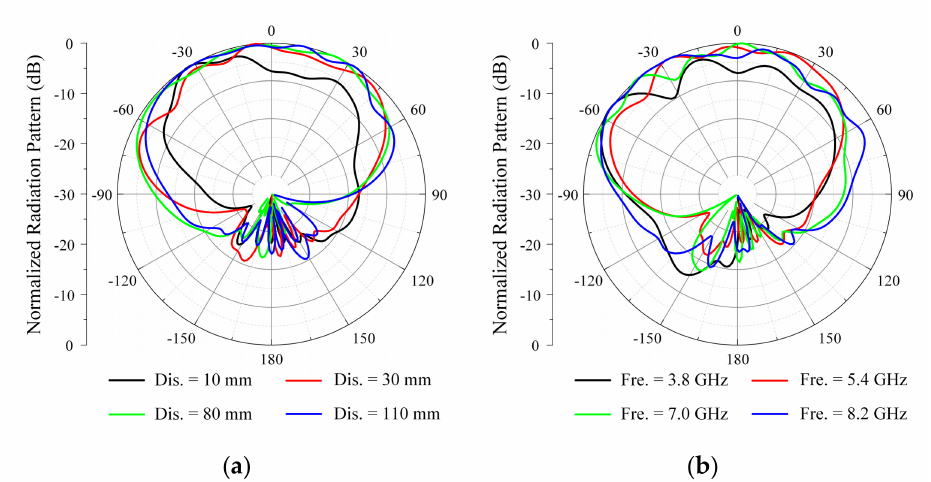
Figure 4. Simulated normalized patterns of the patch antenna in the xz -plane according to ( a ) distance at 6 GHz and ( b ) frequency (distance = 20